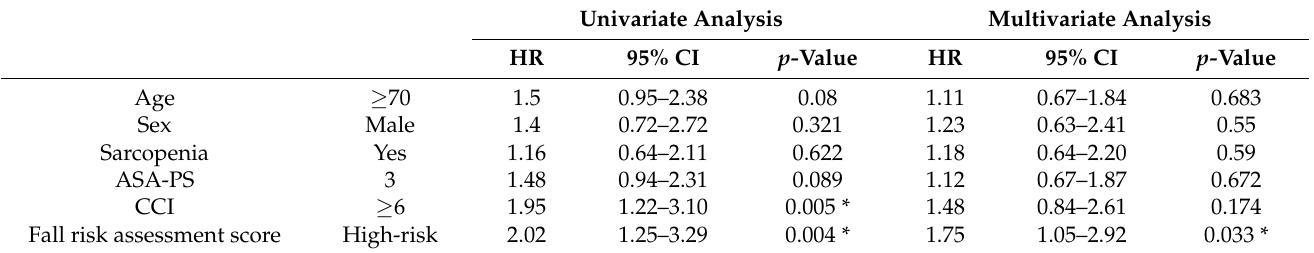
Figure 3. Relapse-free survival in patients with EC ( n = 161) according to their FRAS. Table 3. Prognostic factors for the overall